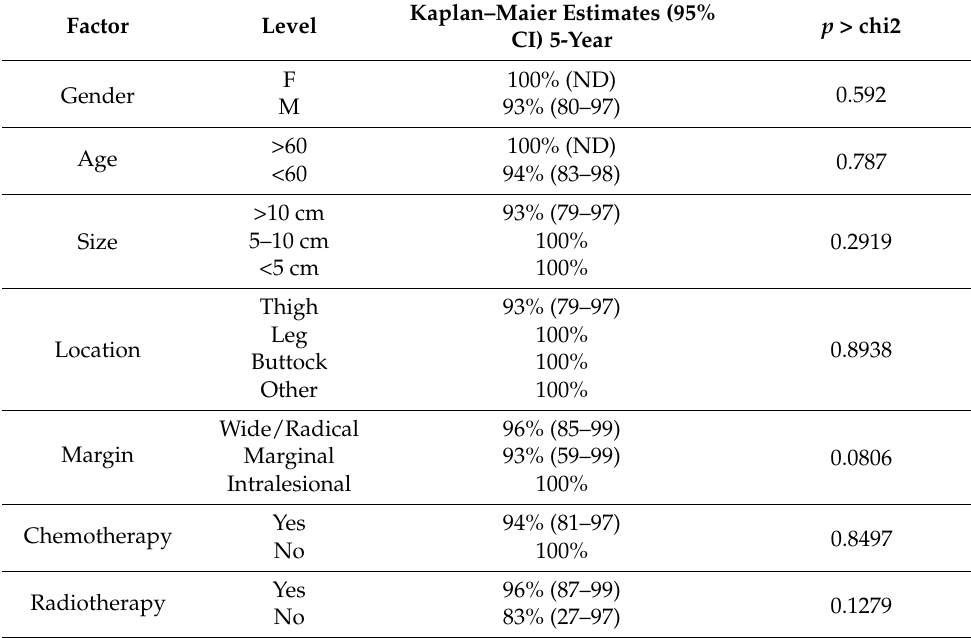
Table 2. Kaplan–Maier Overall Survival (OS) estimates from patient